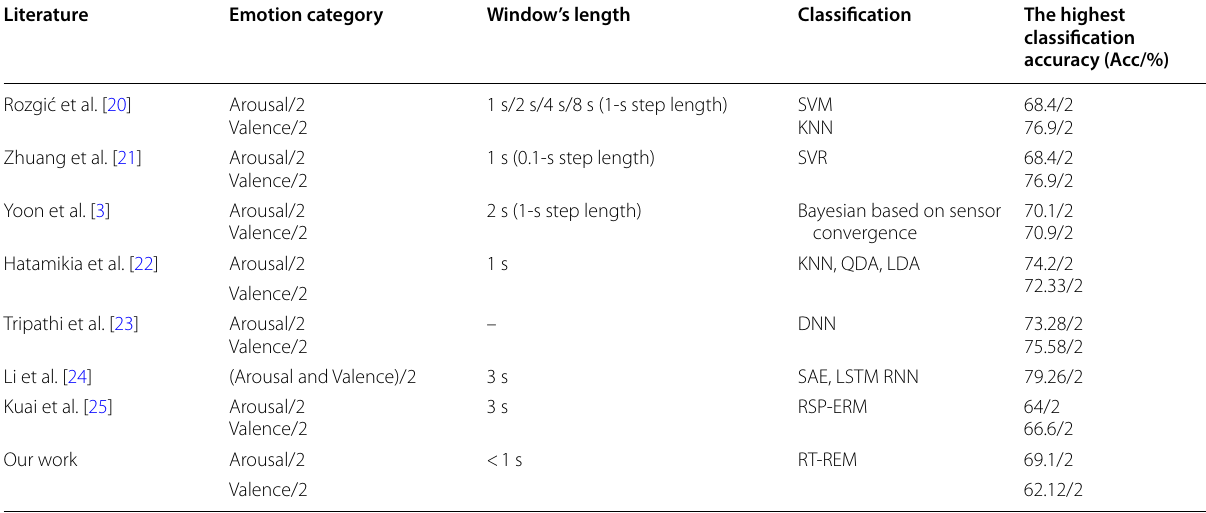
Table 9 Comparison of results that use EEG signals of DEAP dataset for emotion